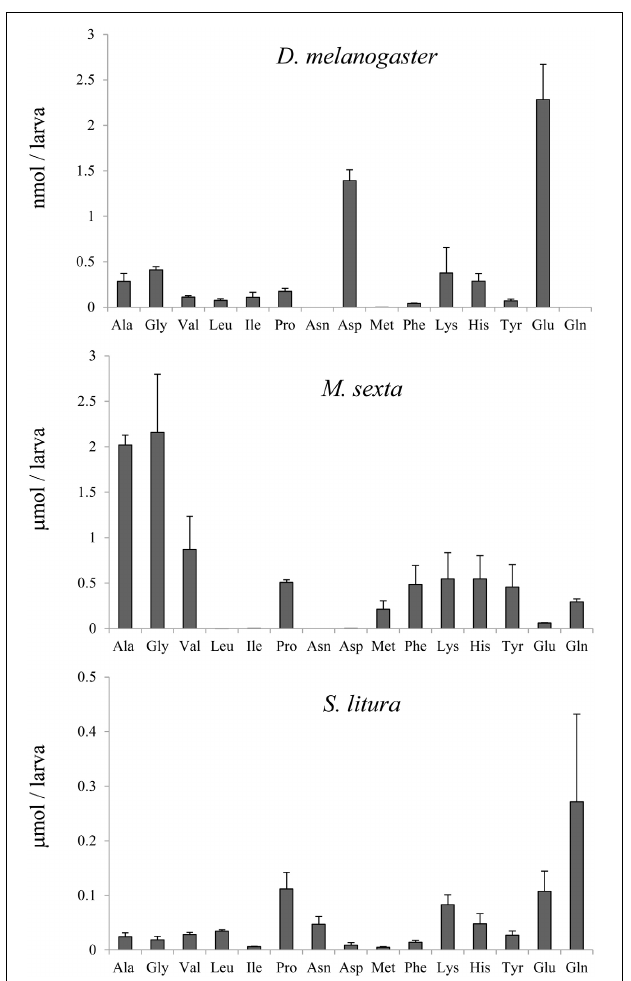
FIGURE 4 | Amino acid compositions in larval midgut tissues of D. melanogaster , M. sexta and S. litura ( n = 3, Mean ± s.e.m.).